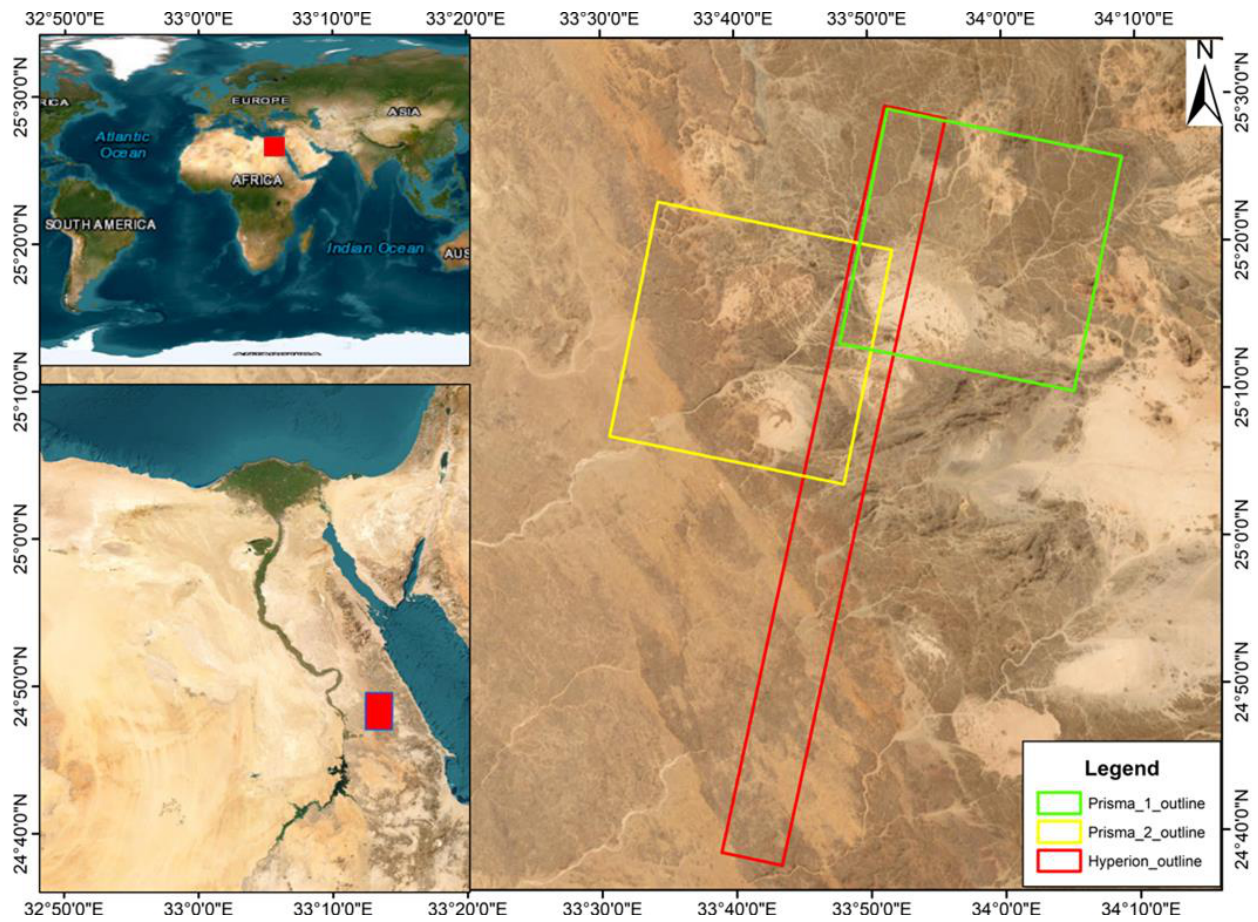
Figure 2. study area with real hyperspectral data coverages. Figure 2. Study area with real hyperspectral data